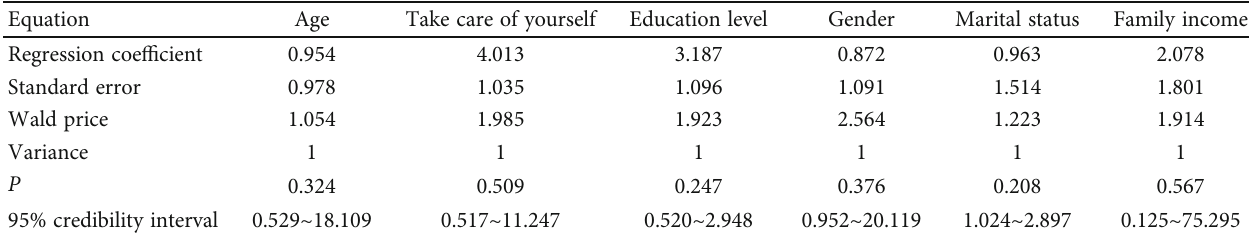
Table 2: Logistics regression analysis of factors of nursing